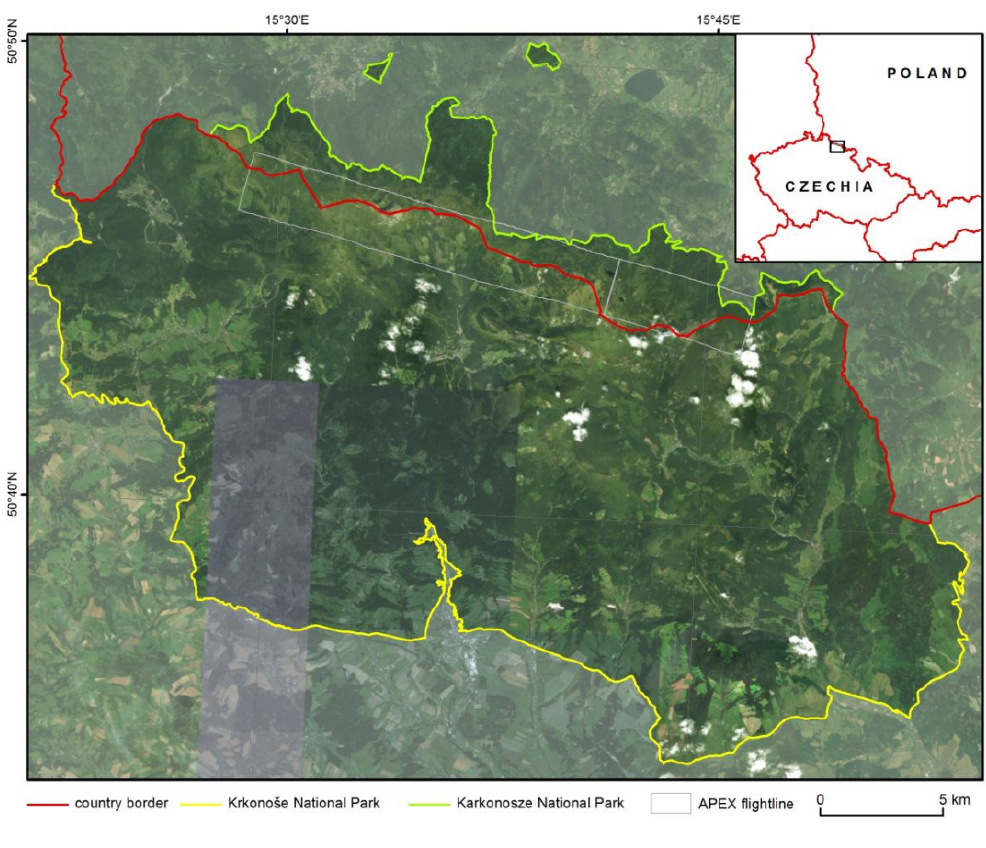
Figure 1. Giant Mountains area.